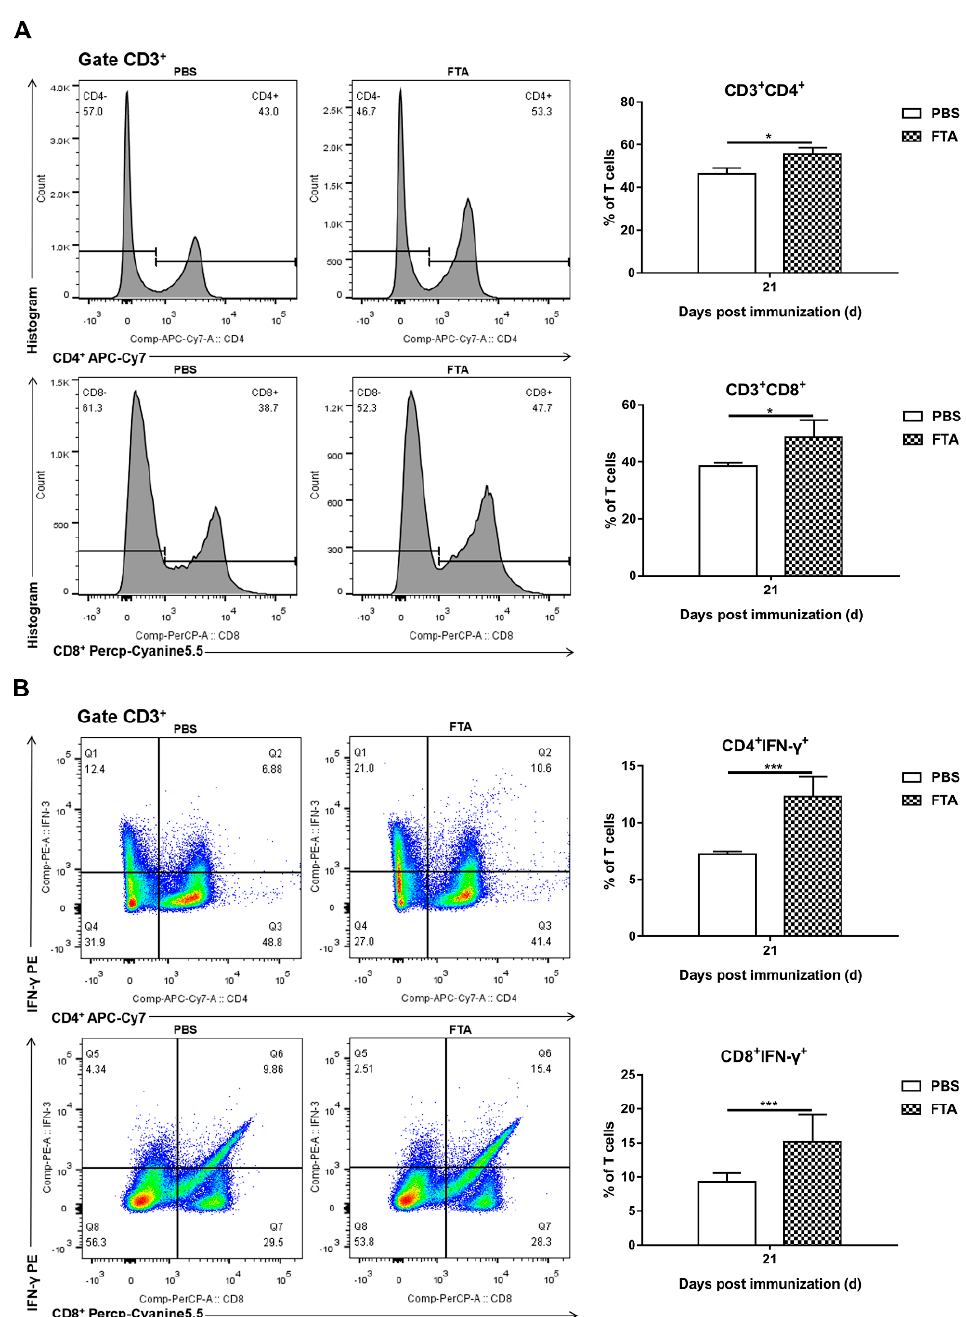
Figure 5. FTA induces the expansion of peripheral blood lymphocytes CD3 + CD4 + , CD3 + CD8 + , CD4 + IFN − γ + , and CD8 + IFN − γ + T cells. ( A ) Flow cytometric analysis of the percentage of CD3 + CD4 + and CD3 + CD8 + cells among CD3 + T cells. ( B ) Flow cytometric analysis of the percentage of CD4 + IFN − γ + and CD8 + IFN − γ + cells among CD3 + T cells. Left: representative flow cytometry dot plot shows the gating strategy for CD3 + CD4 + , CD3 + CD8 + , CD4 + IFN − γ + , and CD8 + IFN − γ + expression in peripheral T cells. Right: The data are the mean percentage of CD3 + CD4 + , CD3 + CD8 + , CD4 + IFN − γ + , and CD8 + IFN − γ + cells among CD3 + T cells ± SEM of three individual mice from each group detected in triplicate. * p < 0.05, *** p < 0.001.